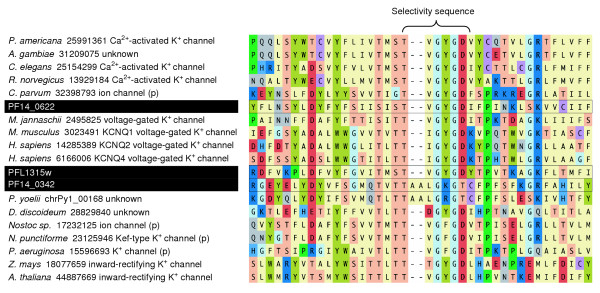
The alignment over the region of the selectivity sequence of the putative P. falciparum novel ion channel protein (PF14_0342) with a representative selection of K+ channel proteins (known and putative) of the voltage-gated ion channel superfamily. P. falciparum sequences are boxed and the protein designators highlighted. The P. yoelii homolog of the PF14_0342 protein is encoded by the chryPy1_00168 locus, which is available at PlasmoDB. For proteins of other organisms, the NCBI accession number and the known or putative (p) function of the protein are given. A larger alignment of the voltage-gated ion channel superfamily, encompassing transmembrane domains (TMDs) 2-6, is presented in Additional data file 9. Residues are shaded as follows: blue, positively charged,; red, negatively charged; orange, hydoxyl; gray, amido; green, proline; purple, cysteine; mid-blue, histidine,; light blue, glycine; olive green, tryptophan and tyrosine; yellow, remaining nonpolar.